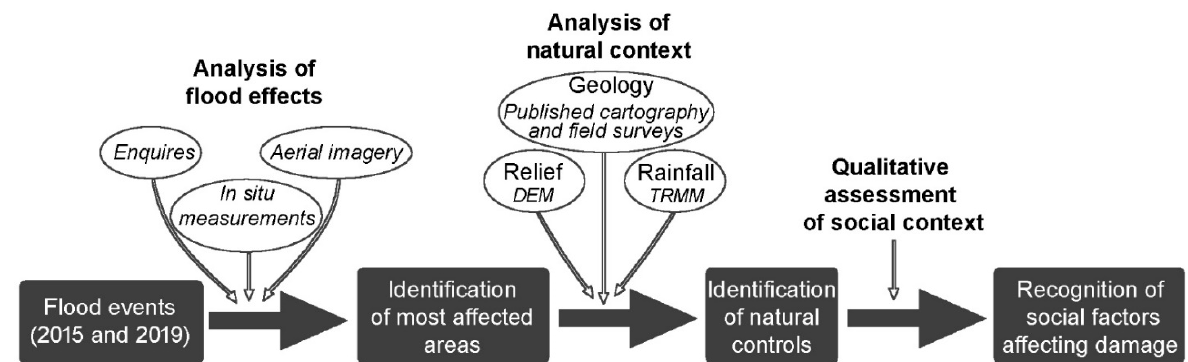
Figure 3. Workflow adopted to establish the causes of the flash flood damage in coastal Benguela.